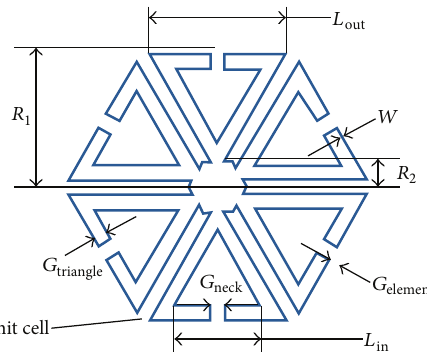
Figure 1: Unit cell structure of the proposed